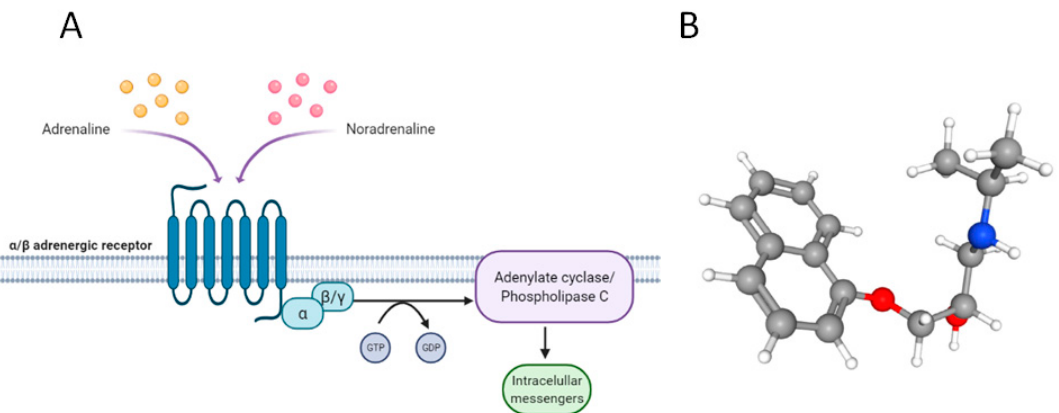
Figure 1. Adrenergic receptors (AR) are classified into two types: α ( α 1 and α 2) and β ( β 1, β 2, and β 3), and their ligands are the catecholamines adrenaline and noradrenaline. ARs are coupled to the G-protein whose activation stimulates phospholipase C or adenylate cyclase, promoting the activation of certain genes ( A ). The atomic structure of the propranolol molecule ( B ).